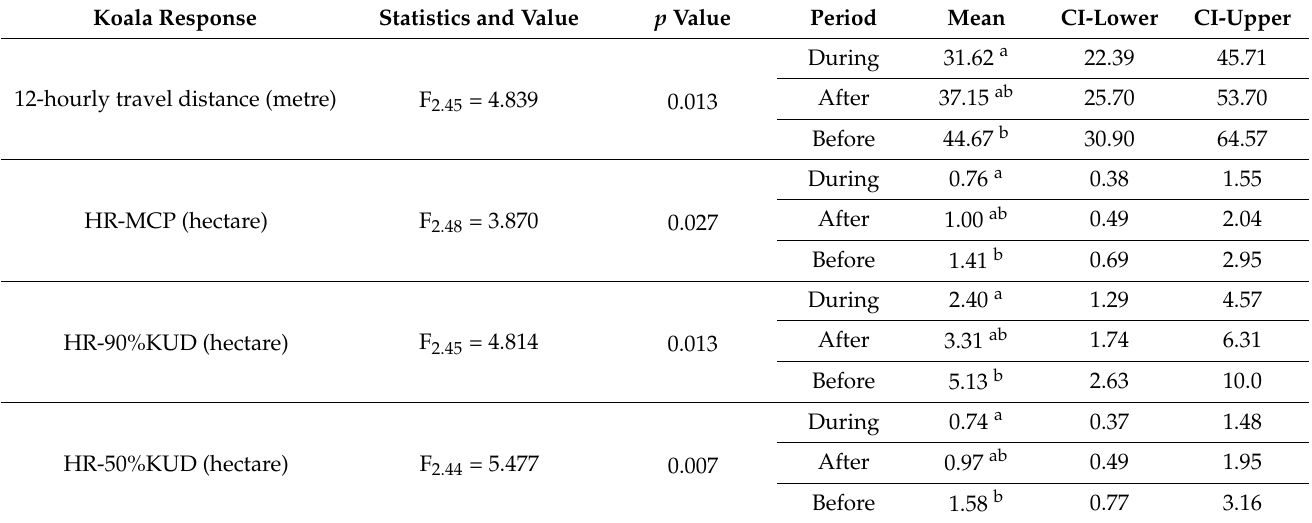
Table 5. Effects of cattle grazing on koala activity levels, 12-hourly travel distances and home range sizes (HR = home range, MCP = Minimal Convex Polygon, KUD = Kernel Utilisation Distribution) in Experiment 1. Within each koala response, periods followed by the same superscript are not significantly different, using Tukey’s test.